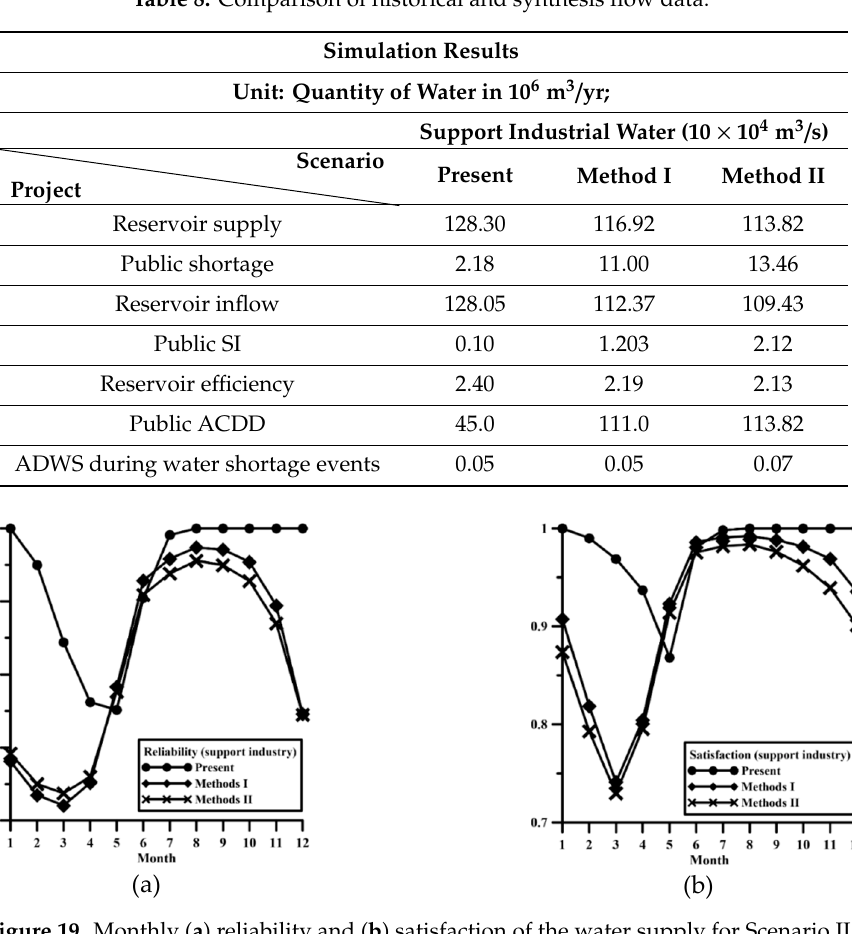
Figure 19. Monthly ( a ) reliability and ( b ) satisfaction of the water supply for Scenario II.